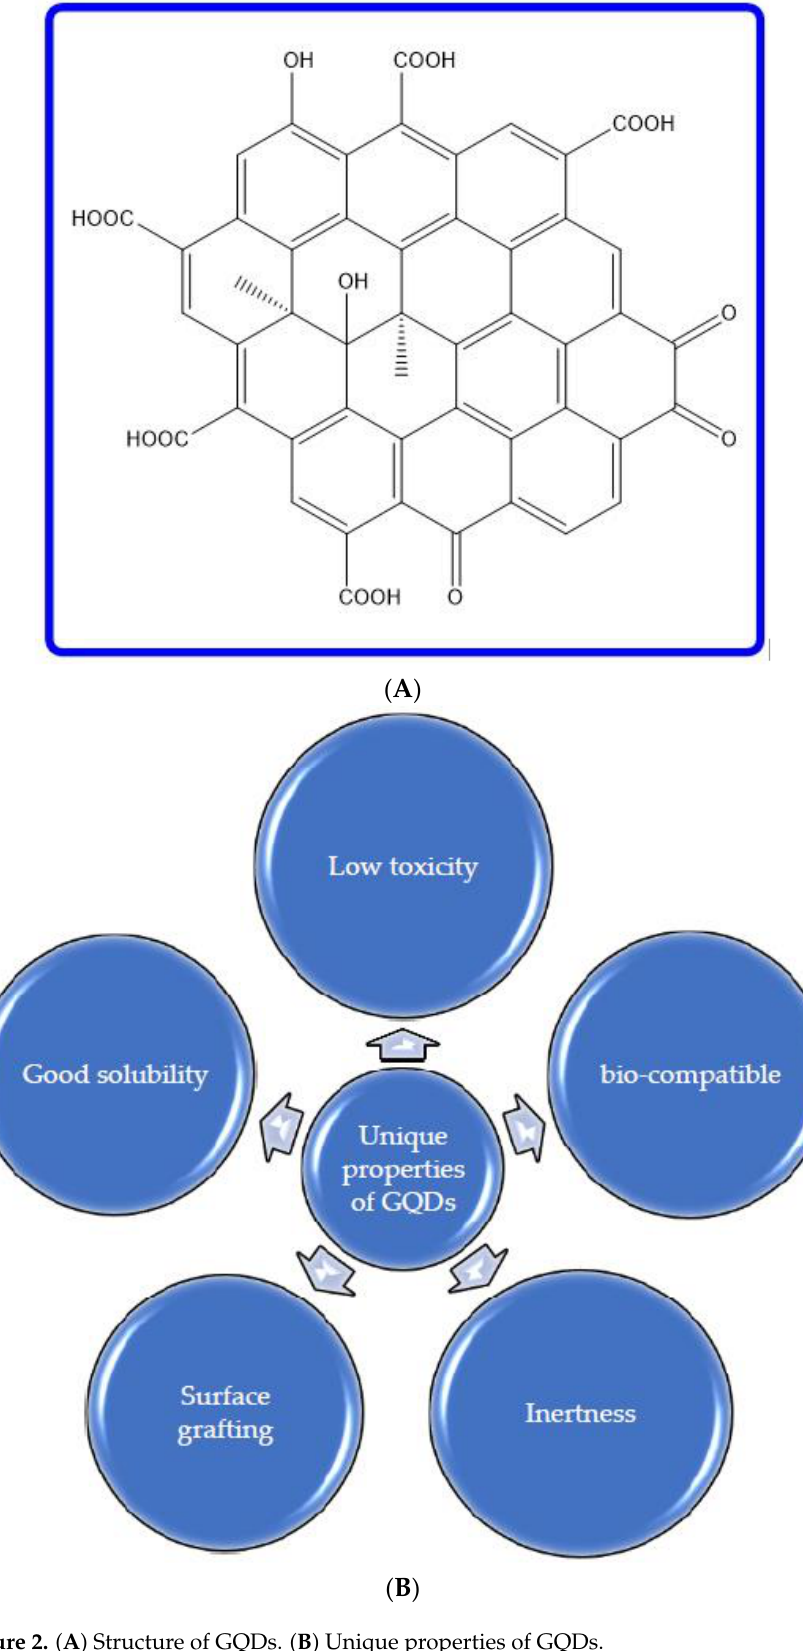
Figure 2. ( A ) Structure of GQDs. ( B ) Unique properties of GQDs.